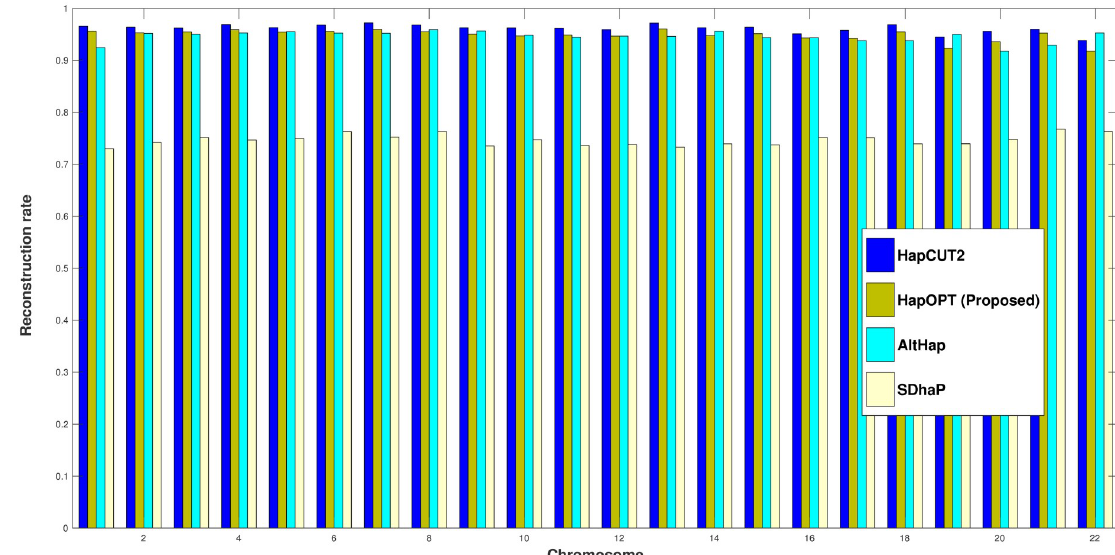
Fig 2. Reconstruction rate of HapOPT, HapCUT2, AltHap, and SDhaP on real fosmid data.